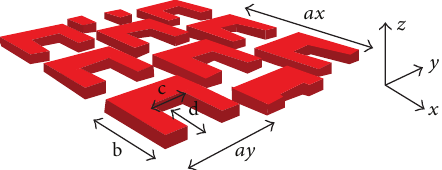
Figure 1: The structure of a triangular lattice structures consisting of gold split-ring resonators with the thickness ℎ = 30.5 nm and the lattice periodic 𝑎 = 𝑎𝑥 = 𝑎𝑦 = 305 nm. There is the unit cell shape with 𝑏 = 219 nm, 𝑐 = 131 nm and 𝑑 = 97 nm. The input light wave is polarized along the 𝑦 direction and propagates along the 𝑧 direction.